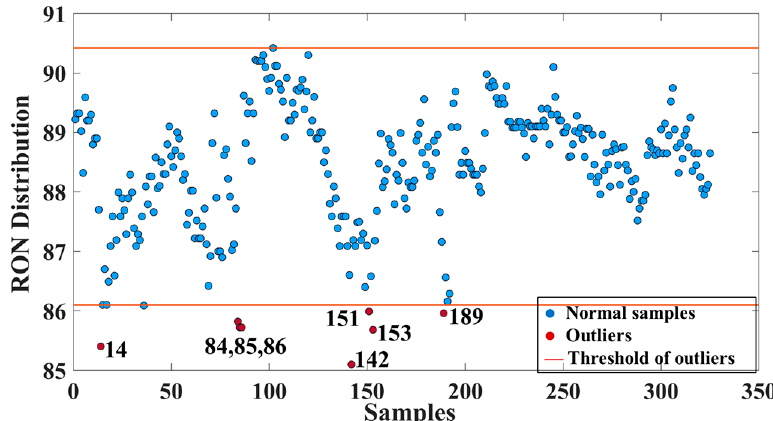
Figure 6. Distribution graph of RON in the measured dataset.